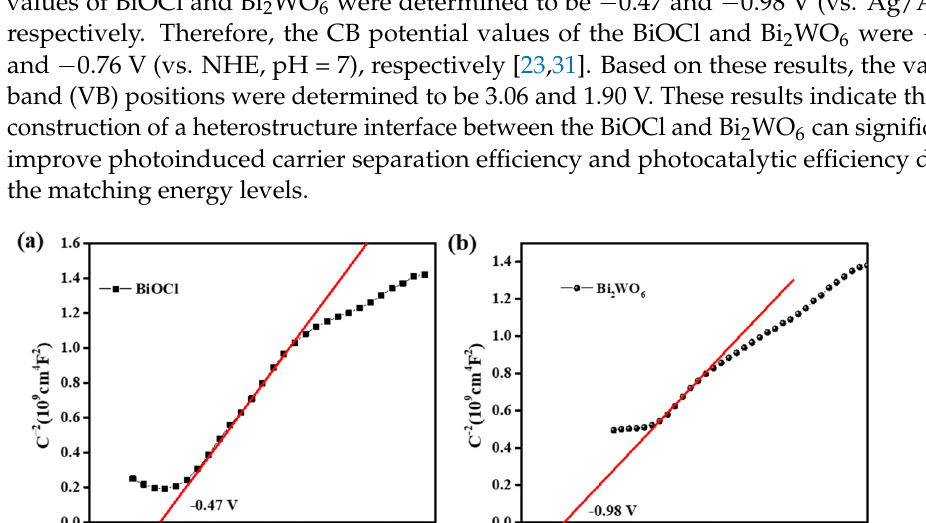
Figure 14. Mott–Schottky curves of the pure BiOCl and Bi 2 WO 6 . Based on the above analysis, the possible mechanism for BPA degradation is portrayed in Figure 15. The heterojunction structure is obtained at the interface between BiOCl and Bi 2 WO 6 . Under light irradiation, Bi 2 WO 6 is excited to form electrons and h + [38,43]. The photogenerated electrons flow to the heterojunction interface, then to the CB of the BiOCl. The accumulation of electrons at the CB of the BiOCl reduce O 2 and PMS in the solution to generate •O 2 − and SO 4• − radicals [5,48]. Meanwhile, the generated h + in the VB of BiOCl can easily accumulate at the surface of Bi 2 WO 6 to directly degrade organic pol- lutants [40]. The •OH cannot be produced by h + in the VB of Bi 2 WO 6 due to its low oxidiz- ing capacity, whereas a small amount of •OH is formed by the contribution of •O 2 − or PMS [26,42]. This result agrees well with the reactive species trapping experiments. Figure 15. A proposed mechanism for BPA degradation via Bi 2 WO 6 /BiOCl nanocomposites with PMS activation. 4. Conclusions In summary, novel Bi 2 WO 6 /BiOCl heterojunction nanocomposites were successfully designed and fabricated by a facile and effective strategy. The heterojunction was fabri- cated by in situ growth of Bi 2 WO 6 on the surface of BiOCl. The Bi 2 WO 6 /BiOCl nanocom- posites possess excellent performance in PMS activation for BPA degradation under visi-